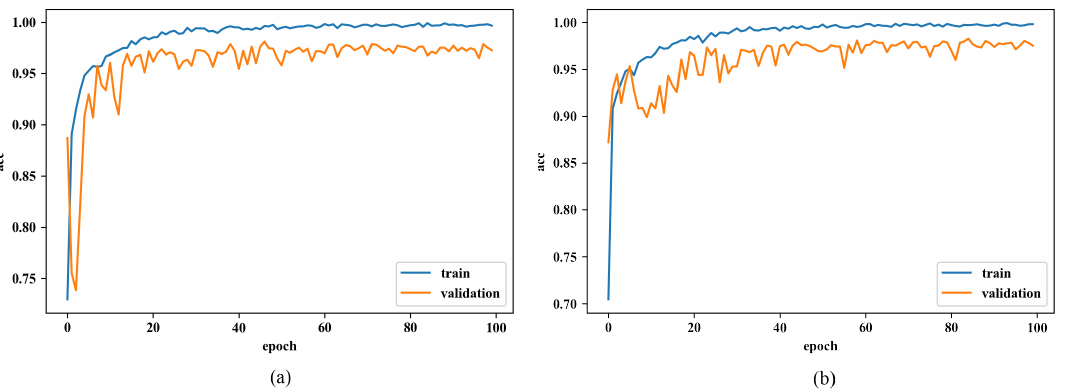
Figure 6. Learning curve of CNN under the small dataset ( a ) using normal initialization, and ( b ) using RGB-based initialization.